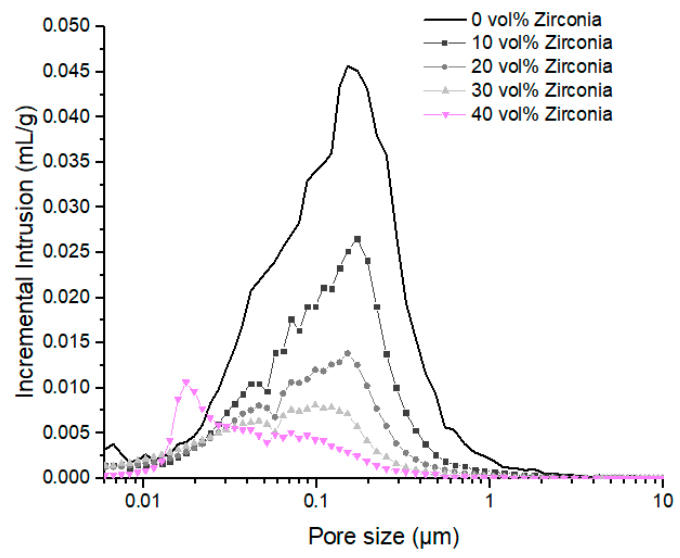
Figure 11. Pore size distribution after waxes solvent extraction of HDPE / PP / wax (70 / 30) blends for different zirconia particle concentrations.